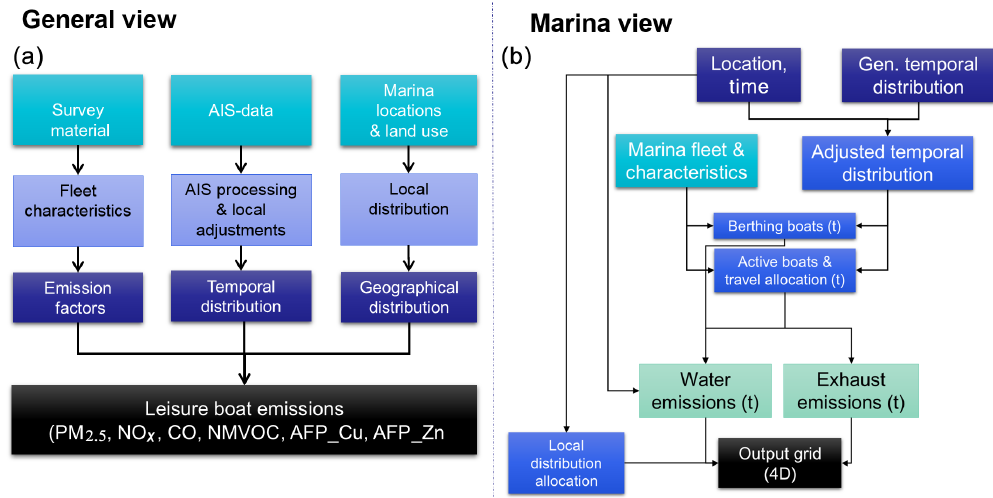
Figure 1. A diagram describing the general modeling approach for the assessment of leisure boat activities and emissions. Table 1. Leisure boat classes and assigned attributes based on Swedish survey data (Swedish Transport Agency, 2010, 2015). For different engine setups three values have been specified in the following order: share of engine setup, the average maximum engine power rating and the average engine load.